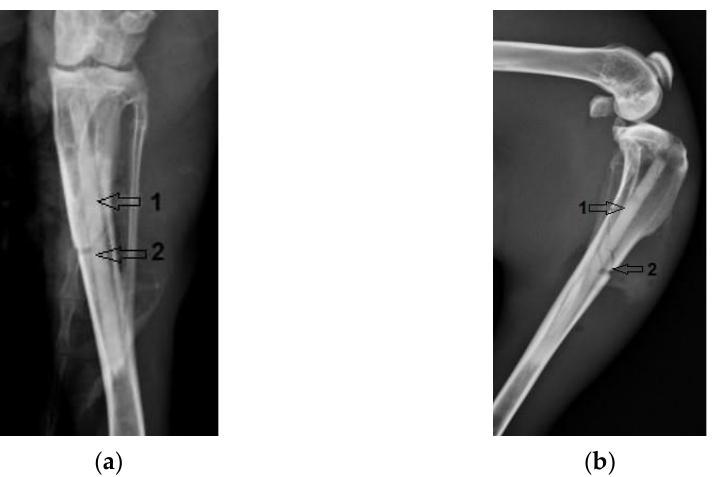
Figure 7. Tibial fracture, after surgery. 1-The Mg-1Ca alloy implant, 2-Fracture line in the tibial diaphysis. ( a ) Coronal view; ( b ) Lateral view.